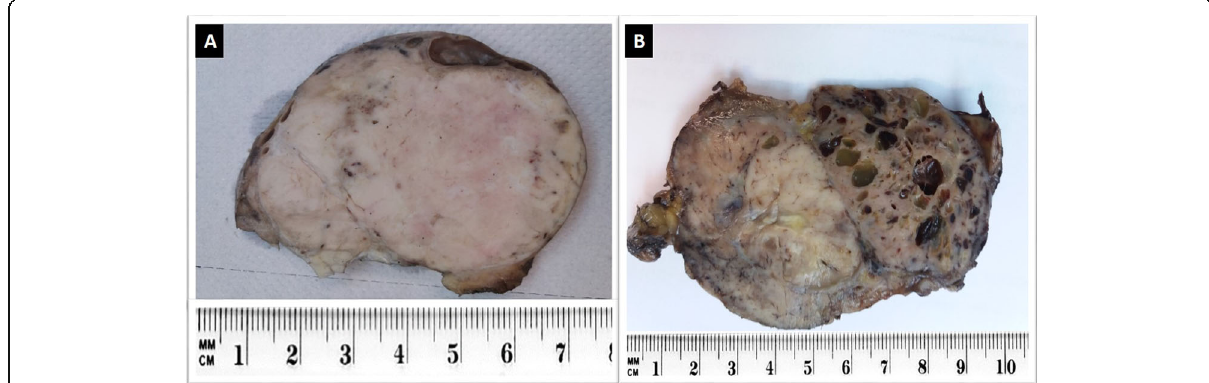
Fig. 1 Gross appearance of SFT: a . Benign SFT appearing as a well-circumscribed, white and firm tumor. b . Malignant SFT of retroperitoneum exhibiting ill-defined borders, variegated cut surface and cystic degeneration